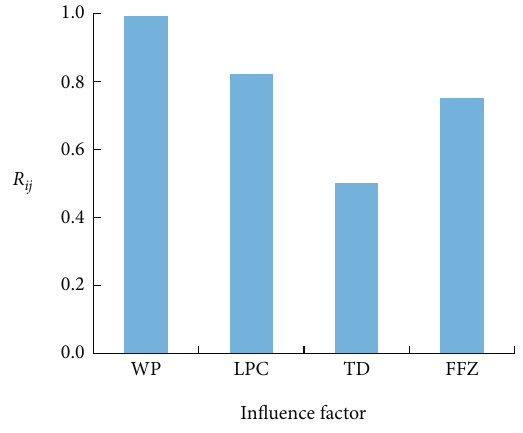
Figure 10: In fl uence analysis of di ff erent input parameters.